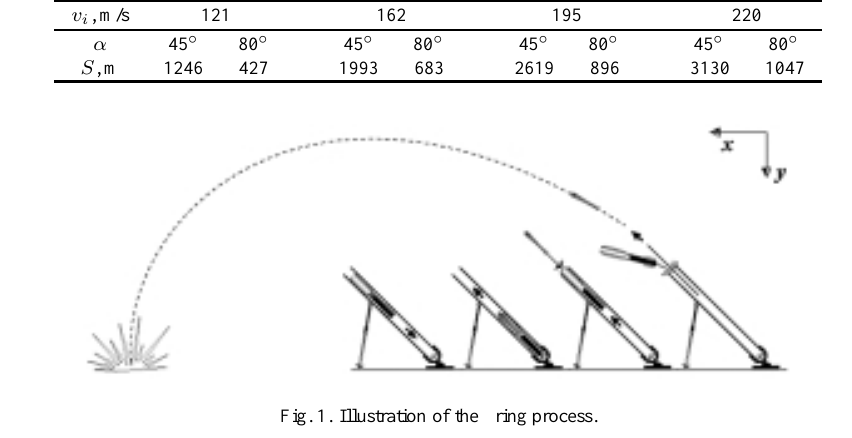
Fig. 1. Illustration of the firing process.